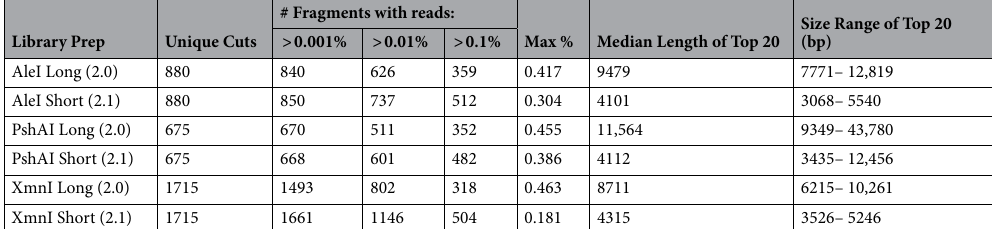
Table 3. Relative behavior of DNA in different PacBio Libraries. Reads from each restriction digest (AleI, PshAI, and XmnI) were compared for both PacBio library preparations, prep 2.0 which favored longer DNA molecules and prep 2.1 which also included many shorter DNA molecules. The number of unique fragments is in column 2 while the number of DNAs with aligned reads are shown in columns 3–5 with the frequency of the DNA molecule with the highest read count listed in column 6 (Max %). The median (column 7) and range (column 8) of lengths for the 20 most frequent DNAs in each library are listed to show the most effective sequencing range for each